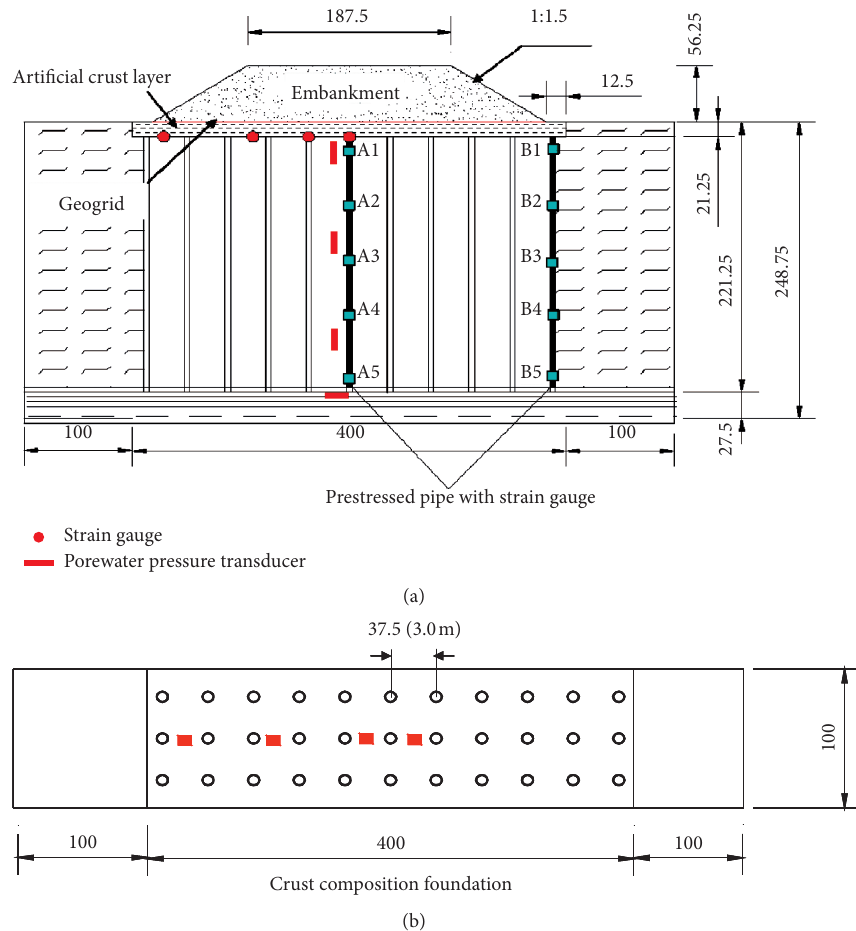
Figure 1: Schematic view and arrangement of a typical test model under (g) (unit: mm). (a) Crust composite foundation. (b) A plane